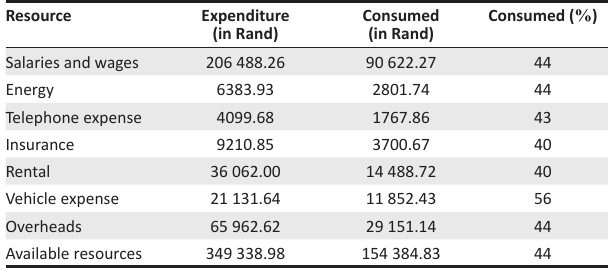
TABLE 7: Resource utilisation by resource group.